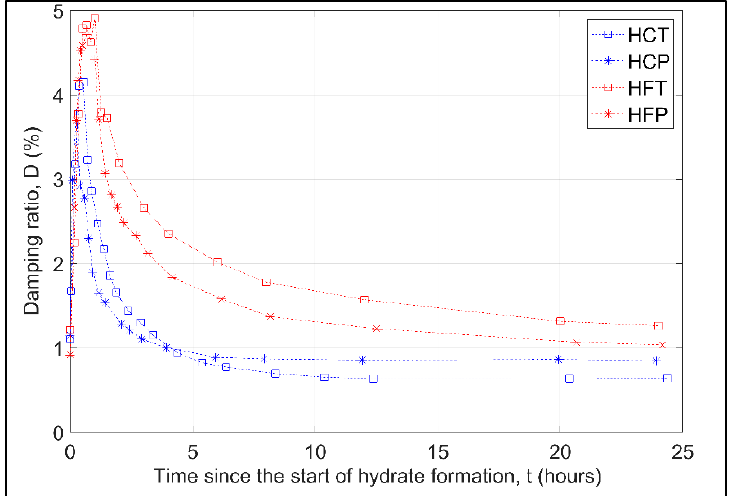
Figure 16. Measured damping ratio for all hydrate-bearing sand samples.